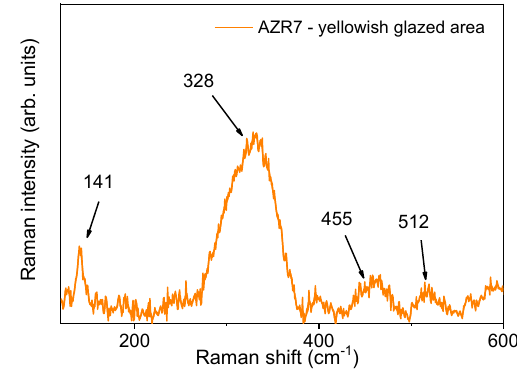
Fig. 3. Experimental Raman spectrum of the yellowish glazed surface of sample AZR7.  exc = 785 nm